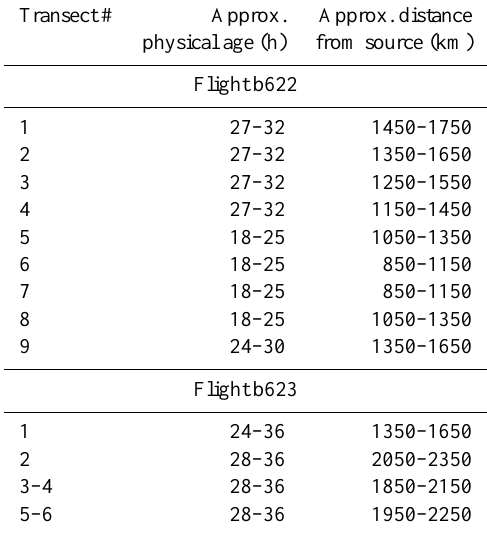
Table 1. Approximate physical transport age and distance of num- bered flight transect midpoints from source fires. Ages were esti- mated by HYSPLIT back trajectories. The large ranges in the deter- mined values are due to the large extent of the source fire region and variability in fire conditions. The distances are given from transect midpoints to the source fire region ( ±